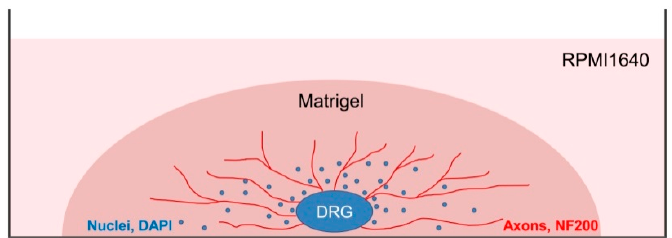
Figure 3. A scheme presenting DRG explant cultured in 3D conditions. Each DRG was placed in a well